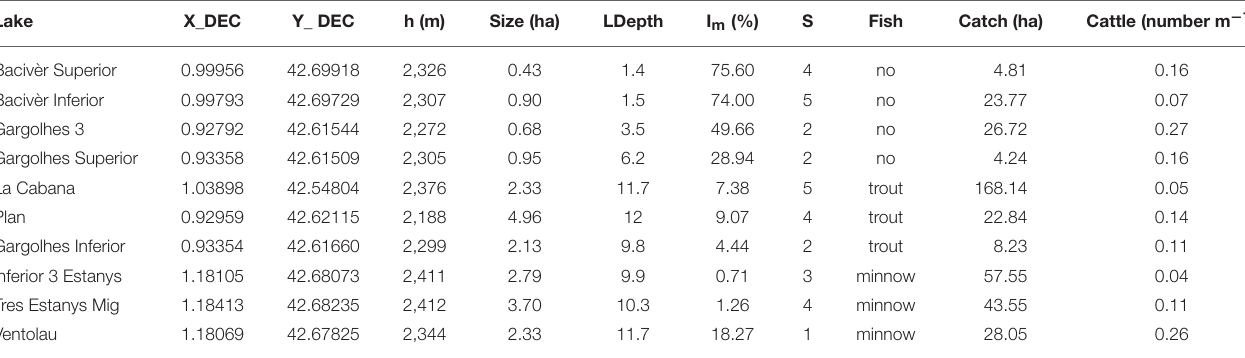
TABLE 1 | Physical and morphological descriptors of the lakes studied including macrophyte richness (S).